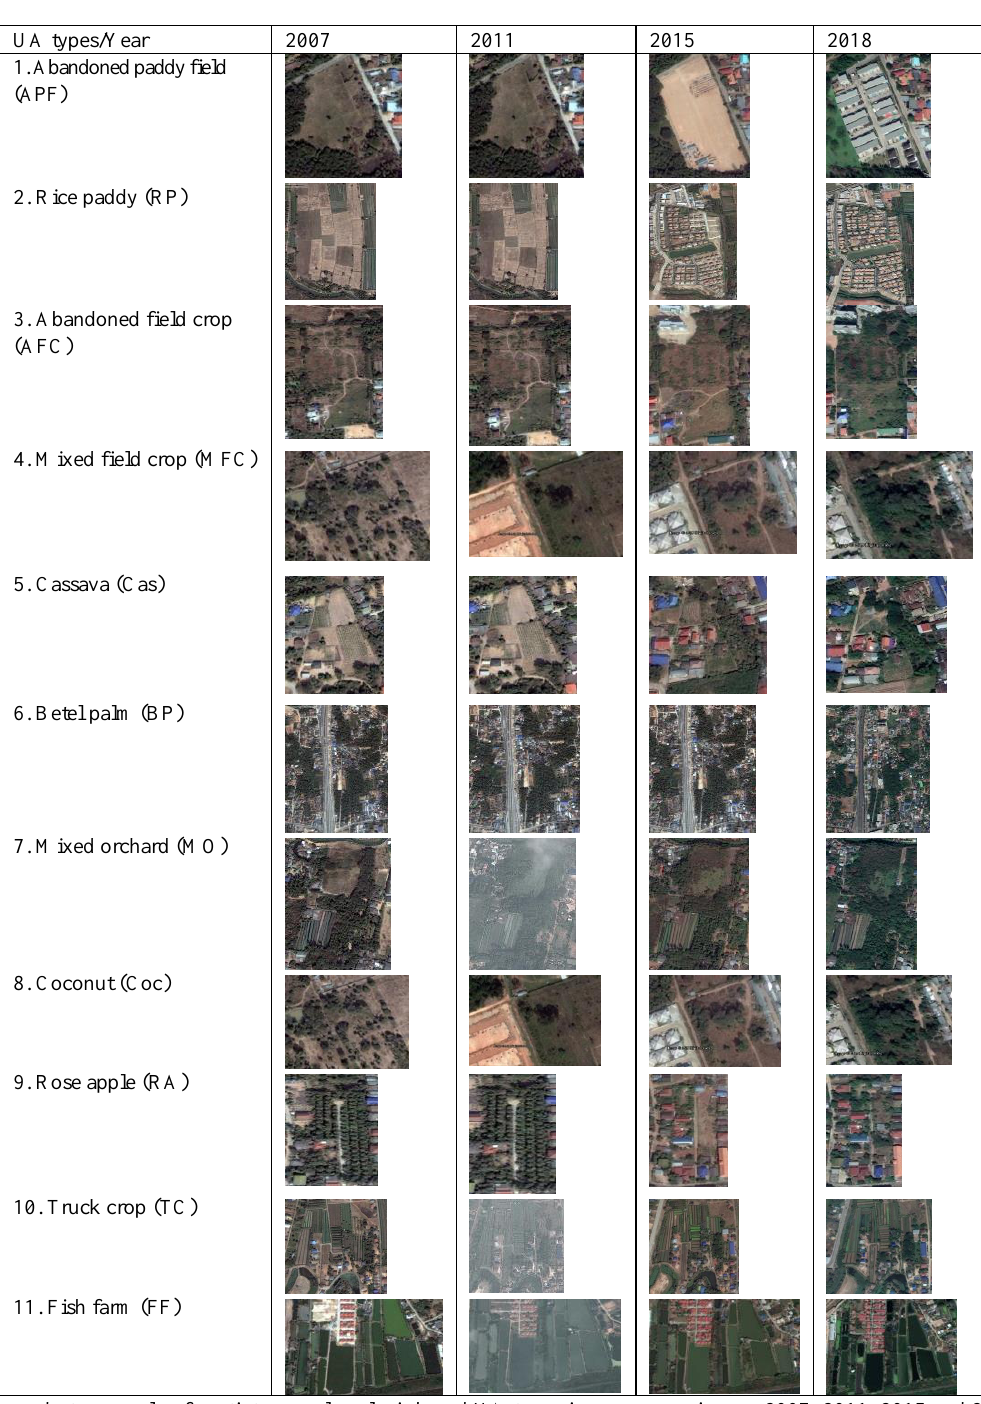
Table 1. Screenshots example of spatiotemporal analysis based UA types in same areas in year 2007, 2011, 2015 and 2018 detected by using GE